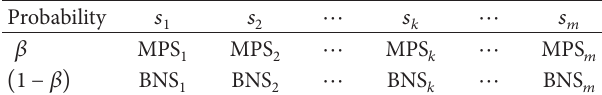
T 5: e strategy pro�le with MPS-BNS as mixed